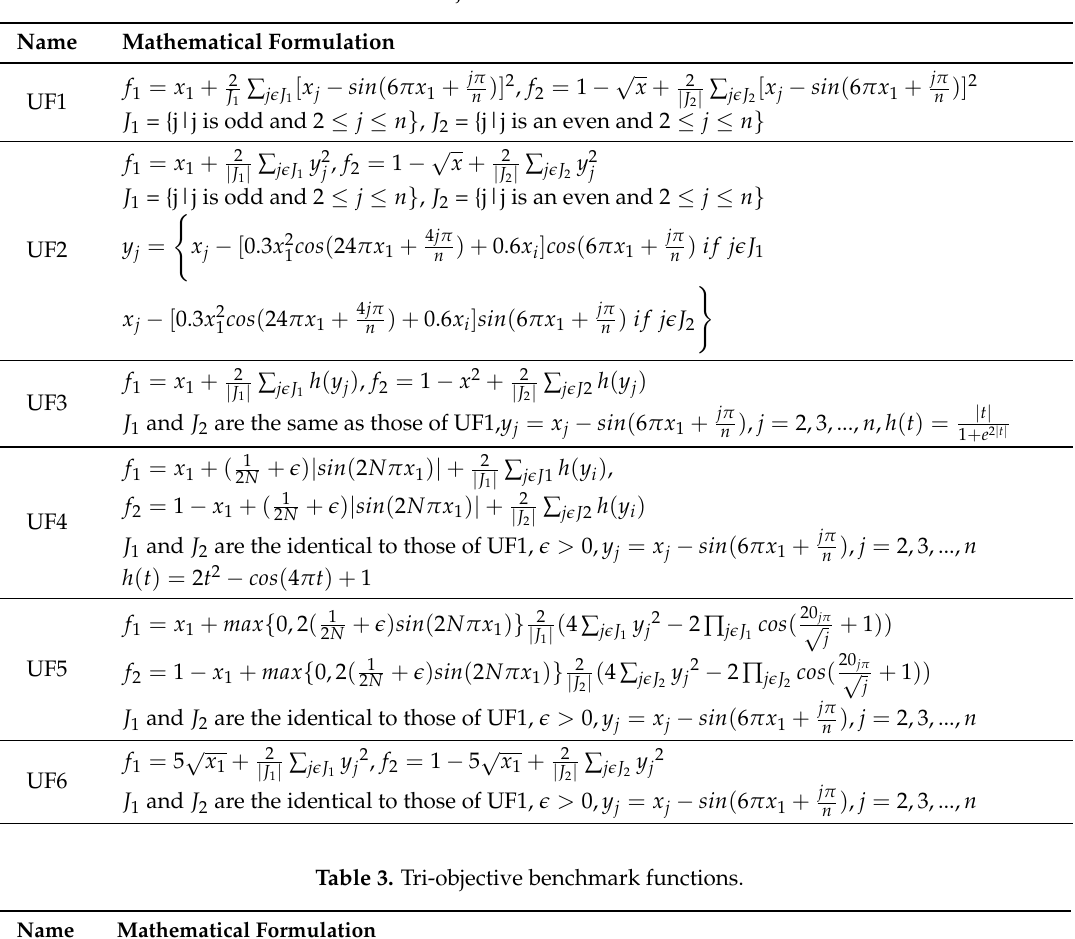
Table 2. Bi-objective benchmark functions.